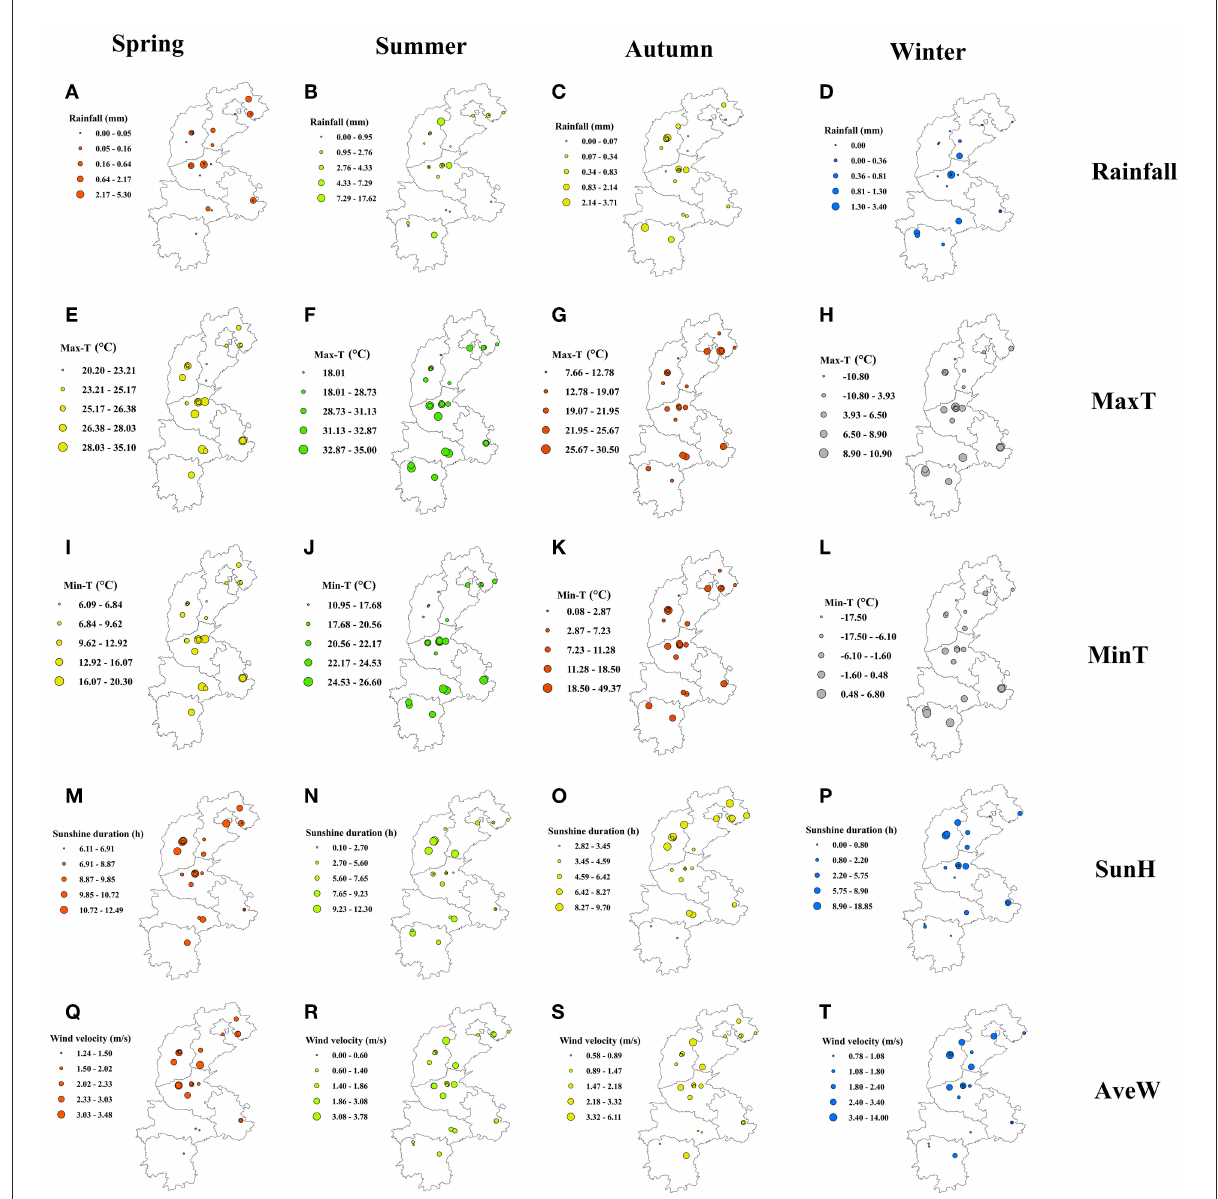
FIGURE4 Spatial distributions of microclimates on days when Sina Weibo users visited wetland parks and posted their facial photos in cities of Central China across four seasons of spring, summer, autumn, and winter of 2020. Microclimatic factors: rainfall, (A–D); maximum daily temperature (MaxT), (E–H) ; minimum daily temperature (MinT), (I–L) ; sunshine duration (SunH), (M–P) ; average wind velocity every 2min (AveW), (Q–T)